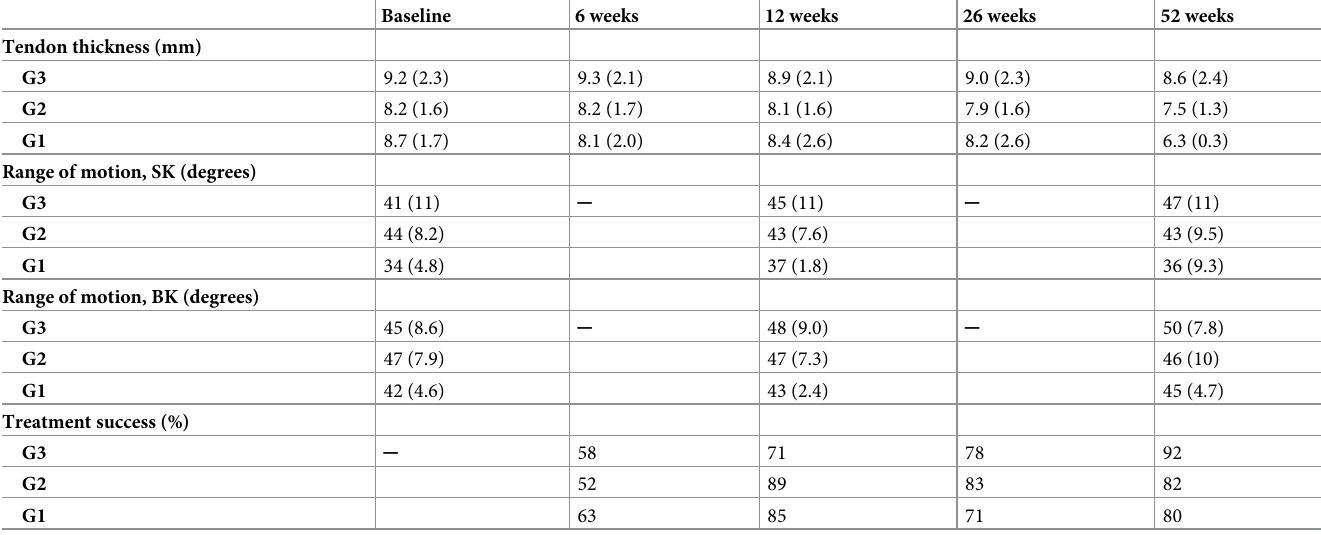
Table 2. Secondary outcome measures of patients treated for Achilles tendinopathy a .